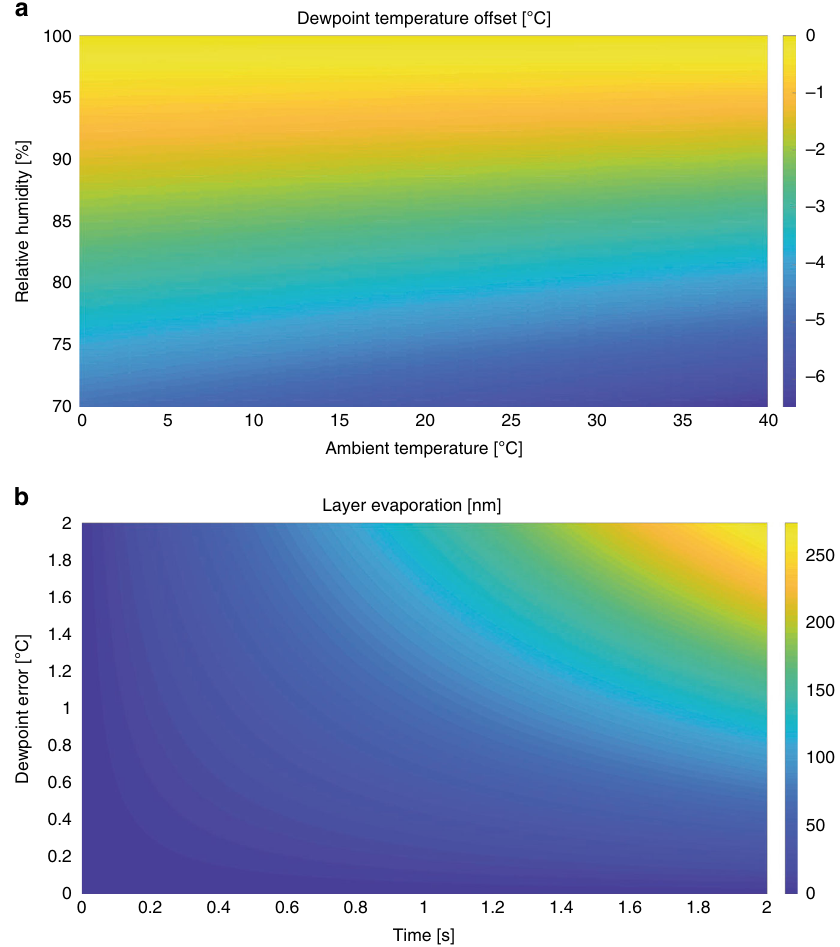
Fig. 1 Dew-point temperature calculations and predictions. a Dew-point temperature offset (color scale, in degrees) as a function of the relative humidity and ambient temperature. E.g., when working at 20 °C and 94% relative humidity, the dew-point temperature would be 1 °C (orange) below the ambient temperature. b Predicted decrease in thickness of a thin sample layer due to evaporation (color scale, in nm/s) with respect to the time and the dew-point error, which is the difference between sample temperature and its dew point. E.g., for a temperature of 1 °C above dew point, 70 nm of the layer is estimated to evaporate within 1